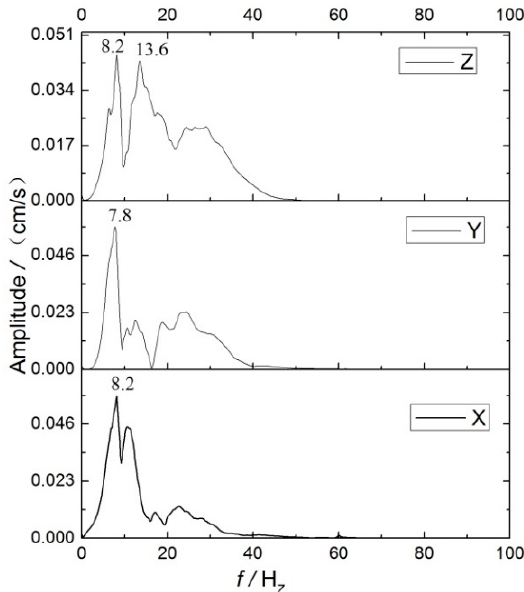
Figure 16. The velocity spectrum of the pipe ( R = 2.7 m and Q = 100 g).